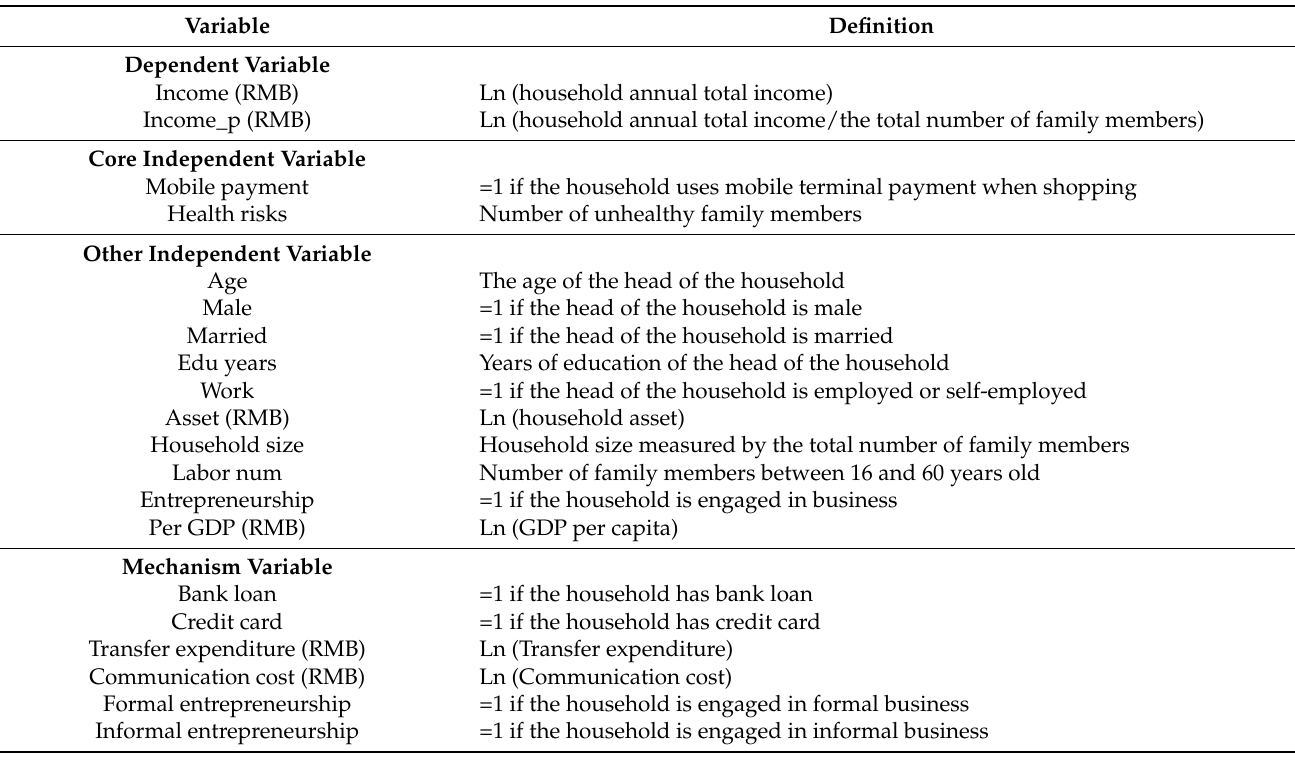
Table 1. Definition of variables.